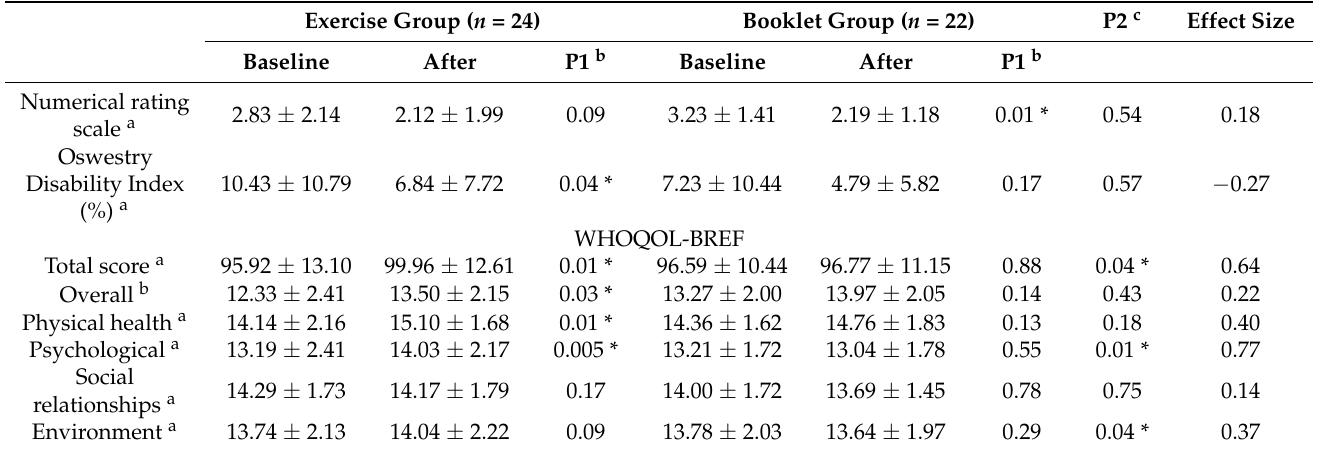
Table 2. Outcome scores at the pretest and